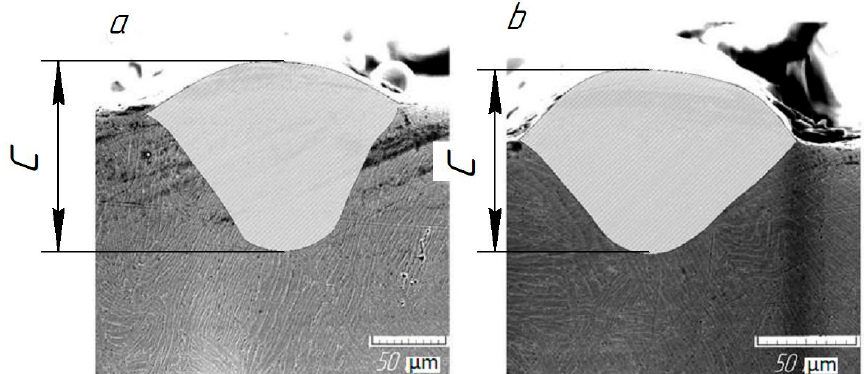
Figure 5. Determination of the minimum depth of the melting pool с was calculated as the distance from the layer surface to the heat-affected zone: ( a ) LPBF single track ( P = 200 W, v = 500 mm/s), ( b ) LPBF single track ( P = 200 W, v = 750 mm/s).